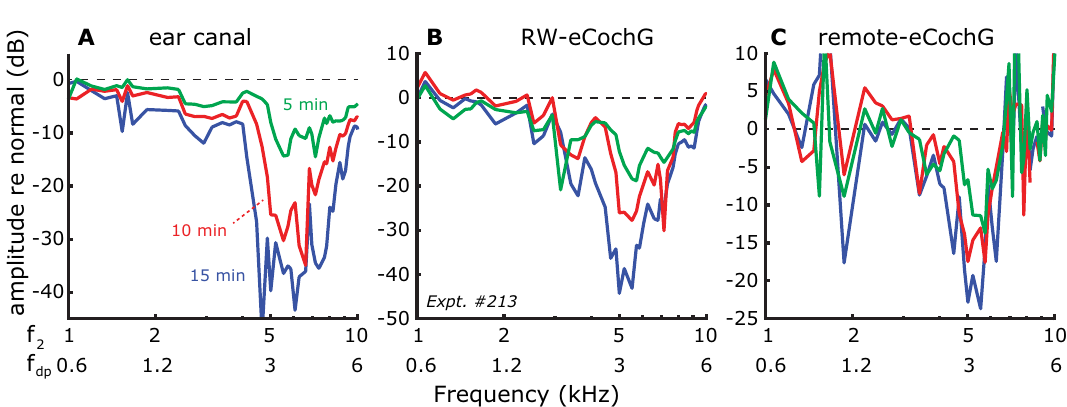
Figure 6. Cumulative effect of exposure to an intense 4-kHz tone on distortion products. Representative examples (Expt. #213) of changes in DP amplitudes in ( A ) ear canal sound pressure, ( B ) RW-eCochG, and ( C ) remote-eCochG following progressively longer exposure to a 100-dB tone at 4 kHz ( colored lines ). DPs were evoked by presenting two stimulus tones (with L 1 = L 2 = 60 dB SPL) using a fixed frequency ratio f 2 /f 1 = 1.25. Data from this experiment are included in the averaged effects shown in Fig.